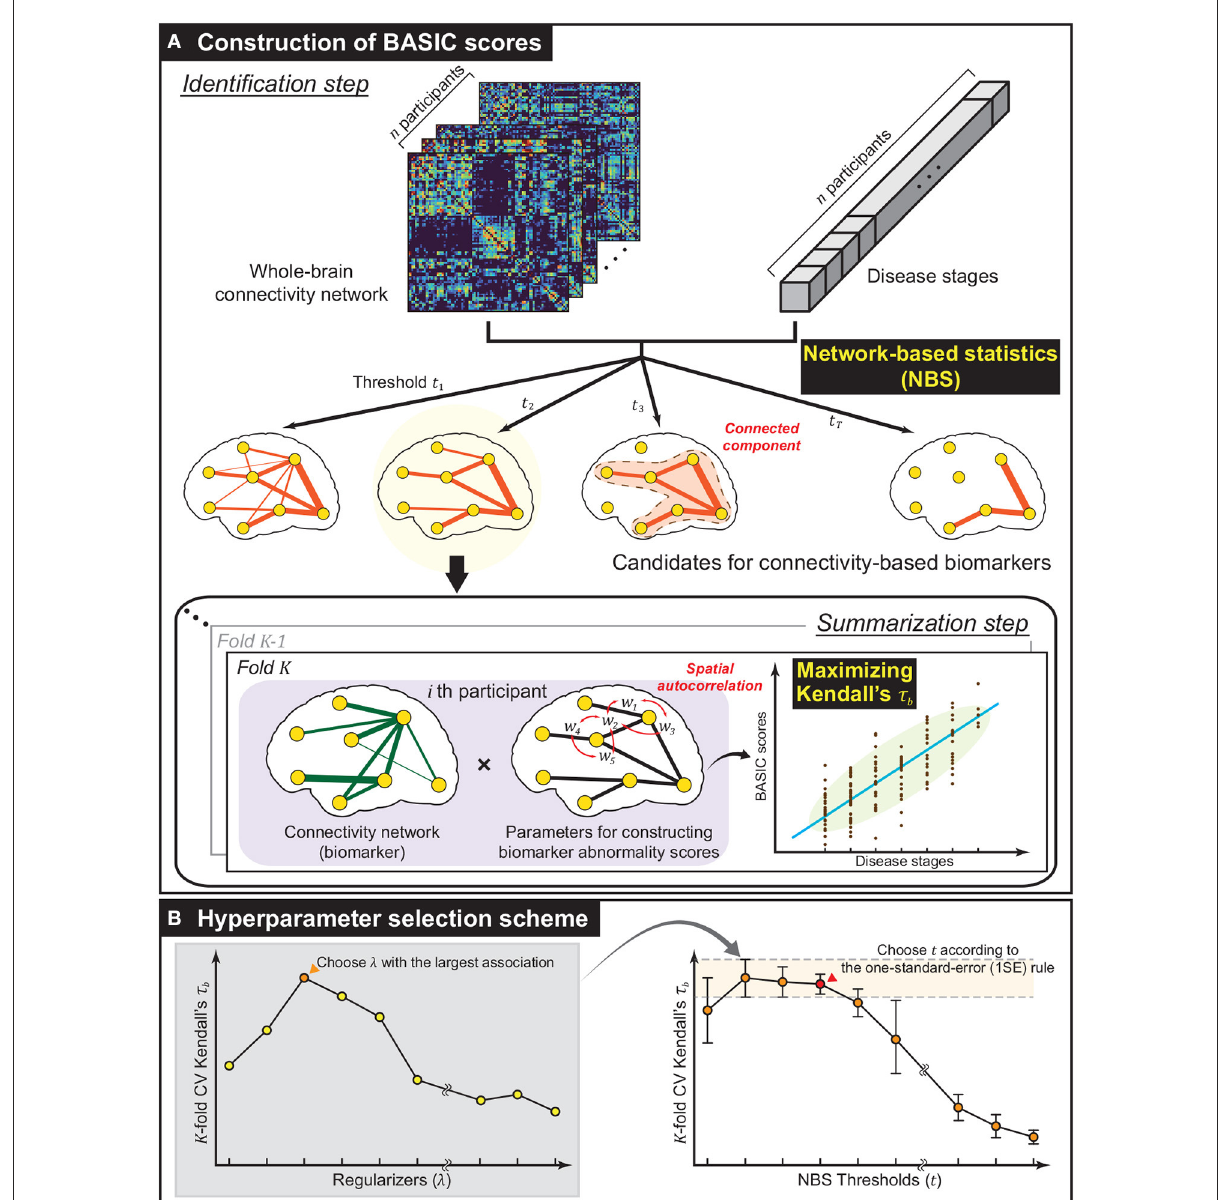
FIGURE1 Methodological overview. (A) The framework established for constructing biomarker abnormality scores associated with disease progression based on brain connectivity. Using network-based statistics (NBS), a collection of biomarker candidates was extracted in the form of connected components of varying extent in the identification step. Next, in the summarization step, Biomarker Abnormality Summarized from the Identified Connectivity (BASIC) scores were constructed in a manner that maximizes Kendall’s rank correlation ( τ b ) to disease stages. In this step, the spatially positive correlation was considered as a regularization in optimization. (B) To improve generalized performance, the biomarker and parameters for constructing BASIC scores were determined based on cross-validation (CV). The optimal regularizer that yielded the best CV Kendall’s τ b for all predefined NBS thresholds was chosen. The optimal NBS threshold was then selected according to the one-standard-error (1SE)